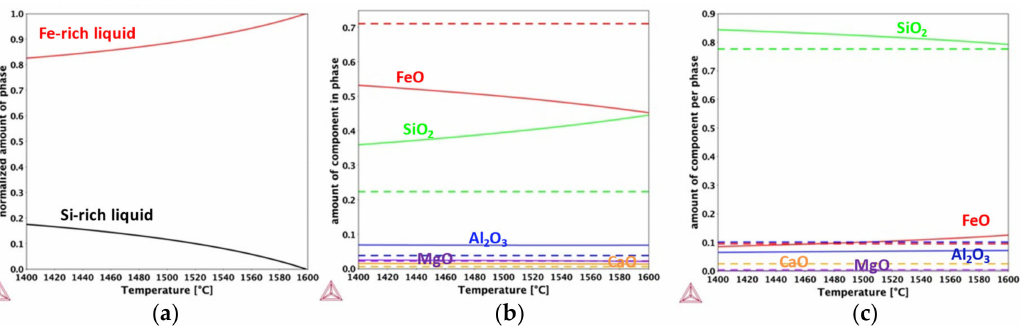
Figure 3. Temperature dependence of ( a ) phase fraction of L Fe -dispersed amoeboids and composition of ( b ) Fe-rich and ( c ) Si-rich liquids. Dashed curves correspond to analytical measurements from TEM and colors correspond to different components (FeO-red, SiO 2 -green, Al 2 O 3 -blue, CaO-orange,